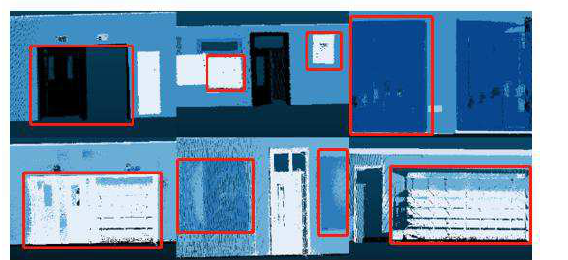
Figure 5. Segmentation results of indoor dataset